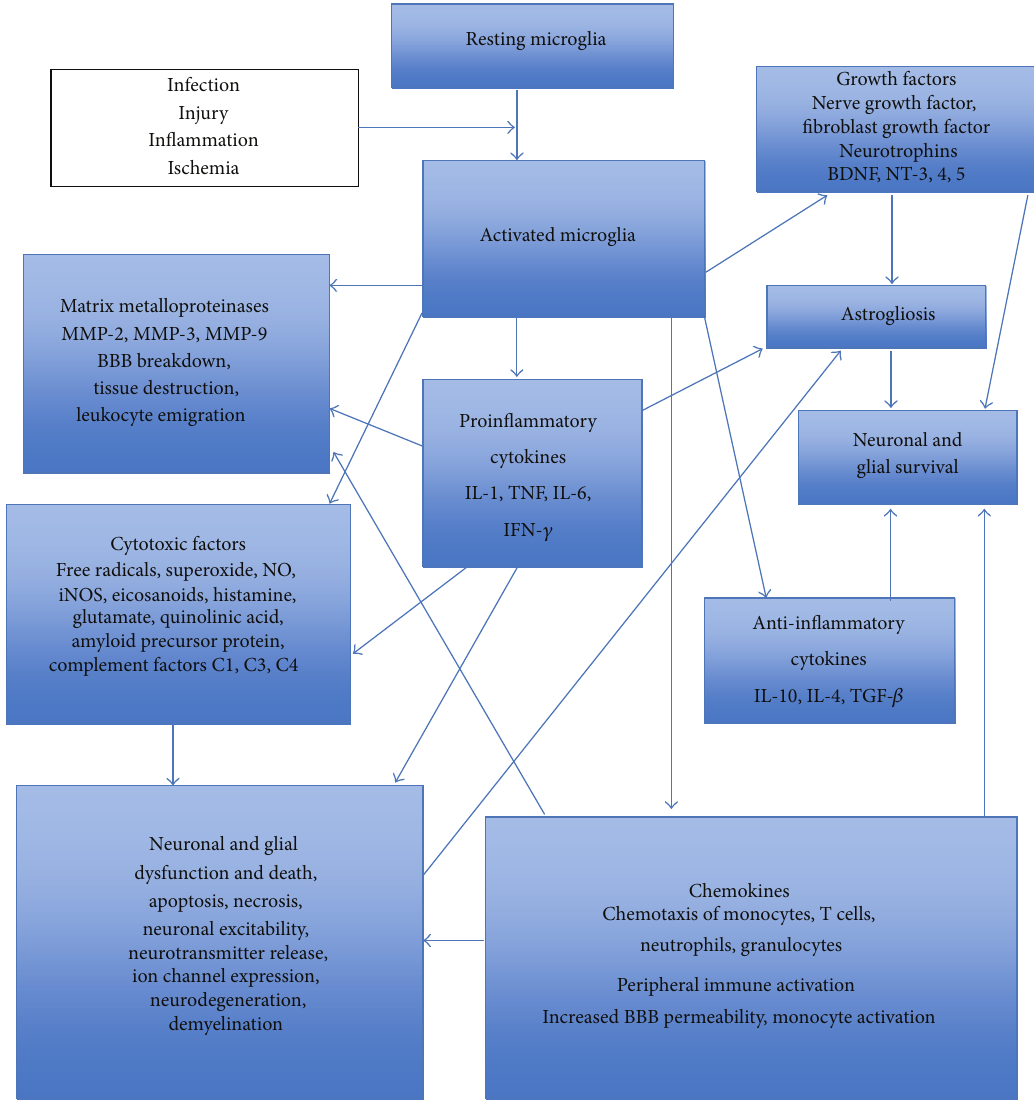
Figure 1: Central role of microglia in